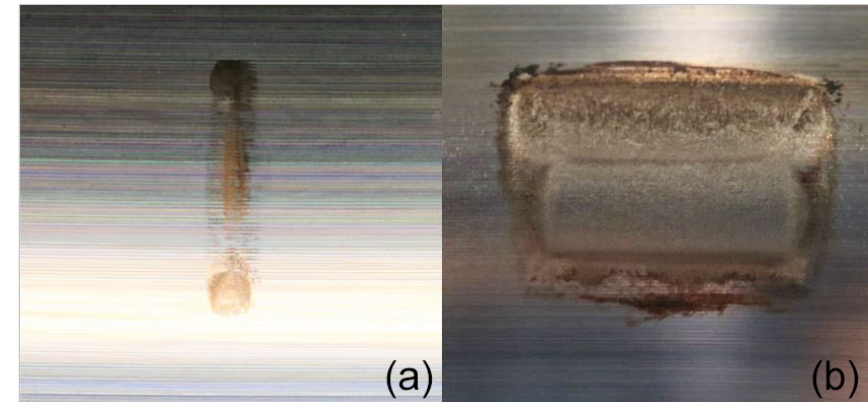
Figure 10. Two wear marks with different sizes: (a) 0.15 ◦ test amplitude (ID VI) and (b) 1 ◦ test amplitude (ID V).